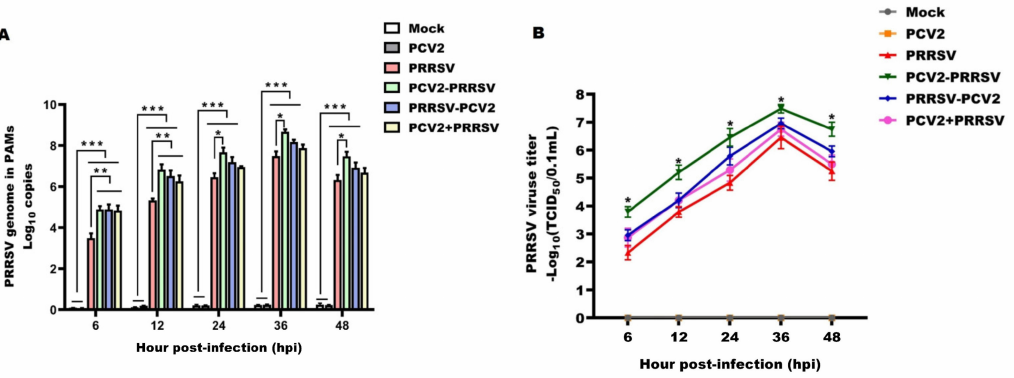
Figure 2. PRRSV viral load of different infection groups. PAMs in the PCV2 alone group (PCV2), the PRRSV alone group (PRRSV) and the PCV2 and PRRSV co − infected group (PCV2 − PRRSV, PRRSV − PCV2 and PCV2 + PRRSV) were inoculated with PRRSV and/or PCV2 at a MOI of 1, respectively. PAMs in the mock group were inoculated with equal RPMI − 1640 medium. Then, PAMs from these groups were collected at 6 h, 12 h, 24 h, 36 h and 48 h post − infection, respectively. ( A ) The levels of viral RNA were measured by RT − qPCR. ( B ) The viral titer of PRRSV in the supernatants was analyzed by TCID 50 . Data are expressed as means ± SD of three independent experiments. Statistically significant differences for the PCV2 and PRRSV co − infected groups vs. the mock − inoculated group and the PCV2 alone group are indicated (*** p < 0.001). Significant differences between groups are also represented (** p < 0.01, * p < 0.05).